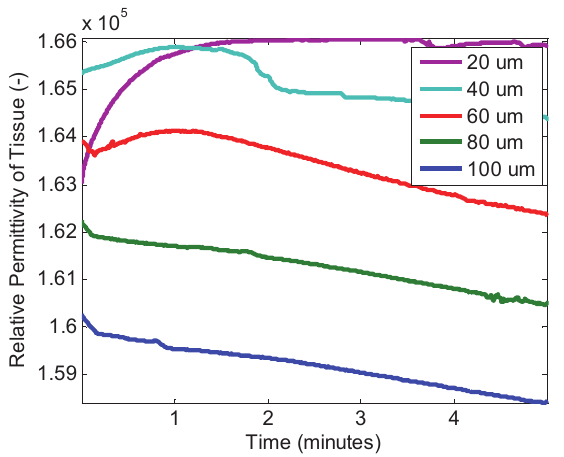
Fig. 16: Measured relative permittivity of alginate hydrogel encapsulated fibroblasts during small strain indentation experiments calculated from eq. 33. Legend denotes final indentation depth.